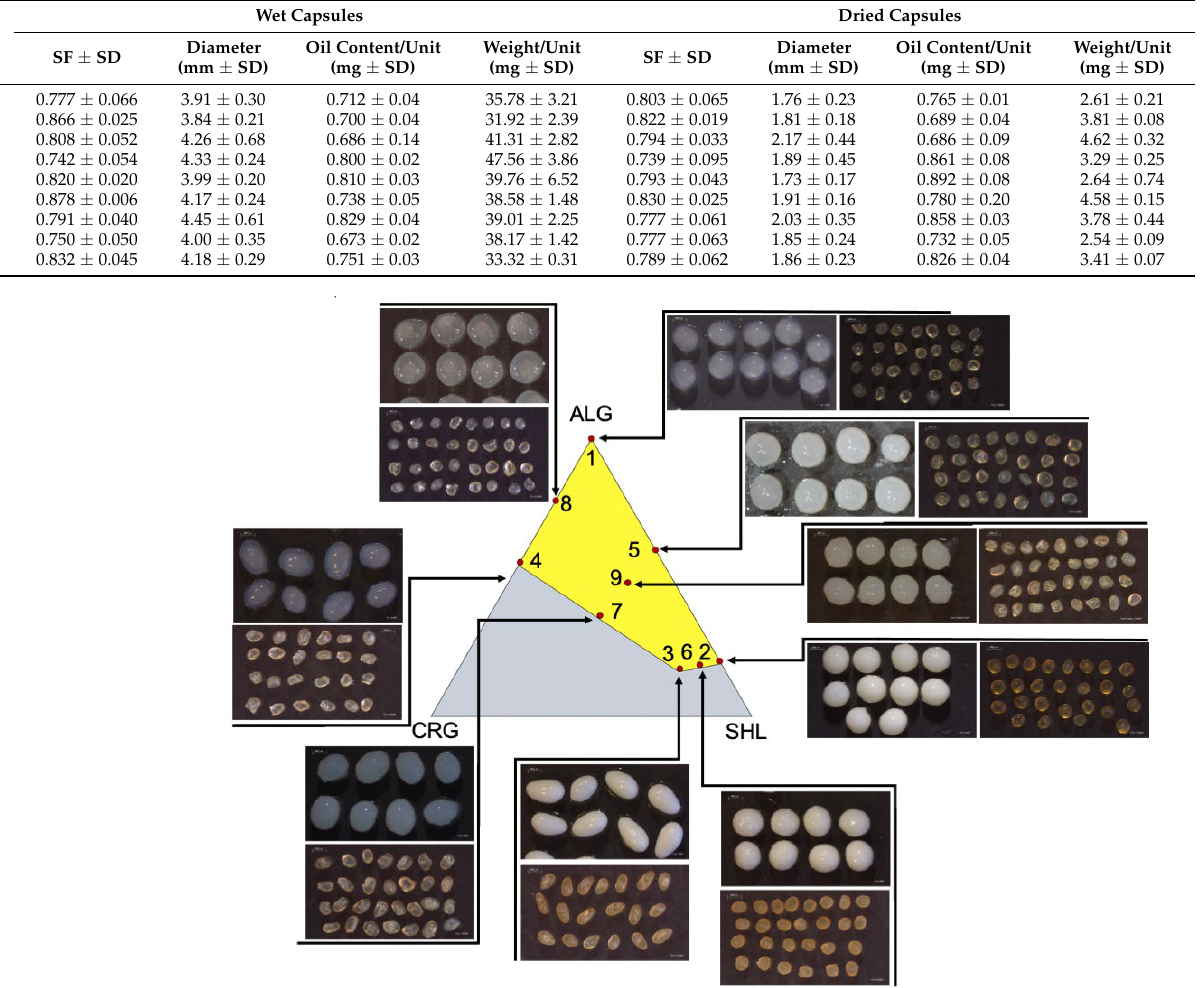
Table 2. Summary of the characterizations evaluated in the mixture design.